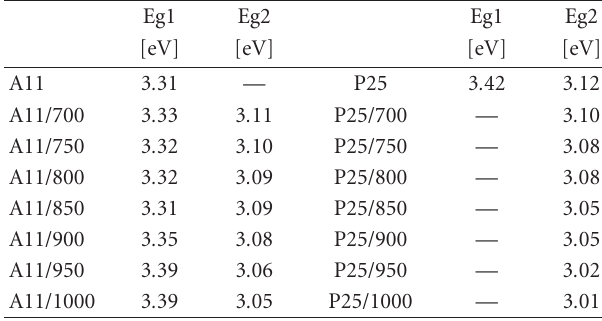
Figure 5: Derivatives obtained from UV-Vis/DR spectra for A11 photocatalyst samples. From bottom to top: untreated A11,